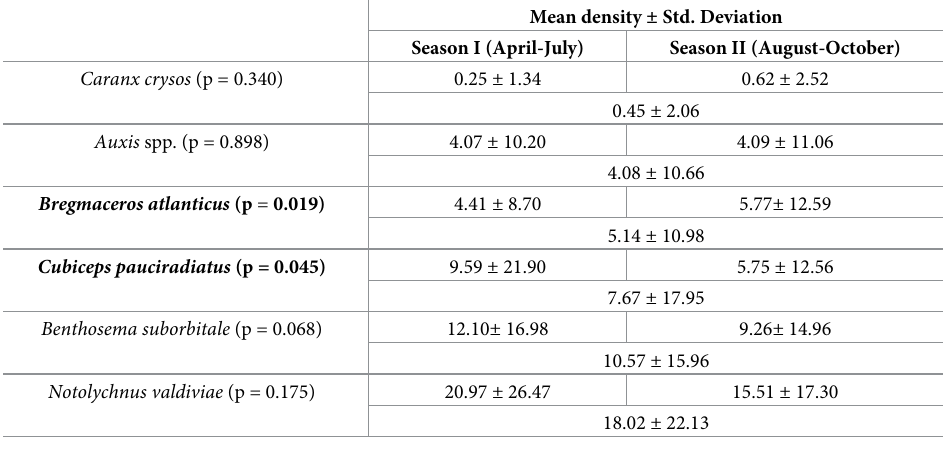
Table 3. Mean seasonal density (larvae 1000 m -3 ) for cruises (6 per season) and total density conducted between 2011 and 2018 in the deep-water region of the southern GoM. Mean density ± Std.